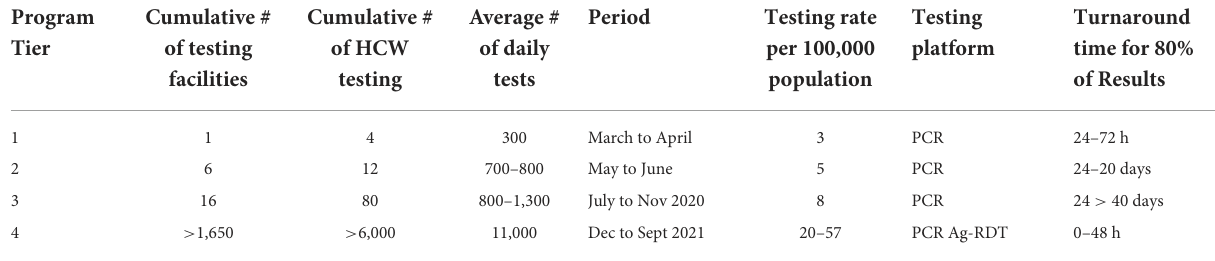
TABLE 1 Decentralization output through the four